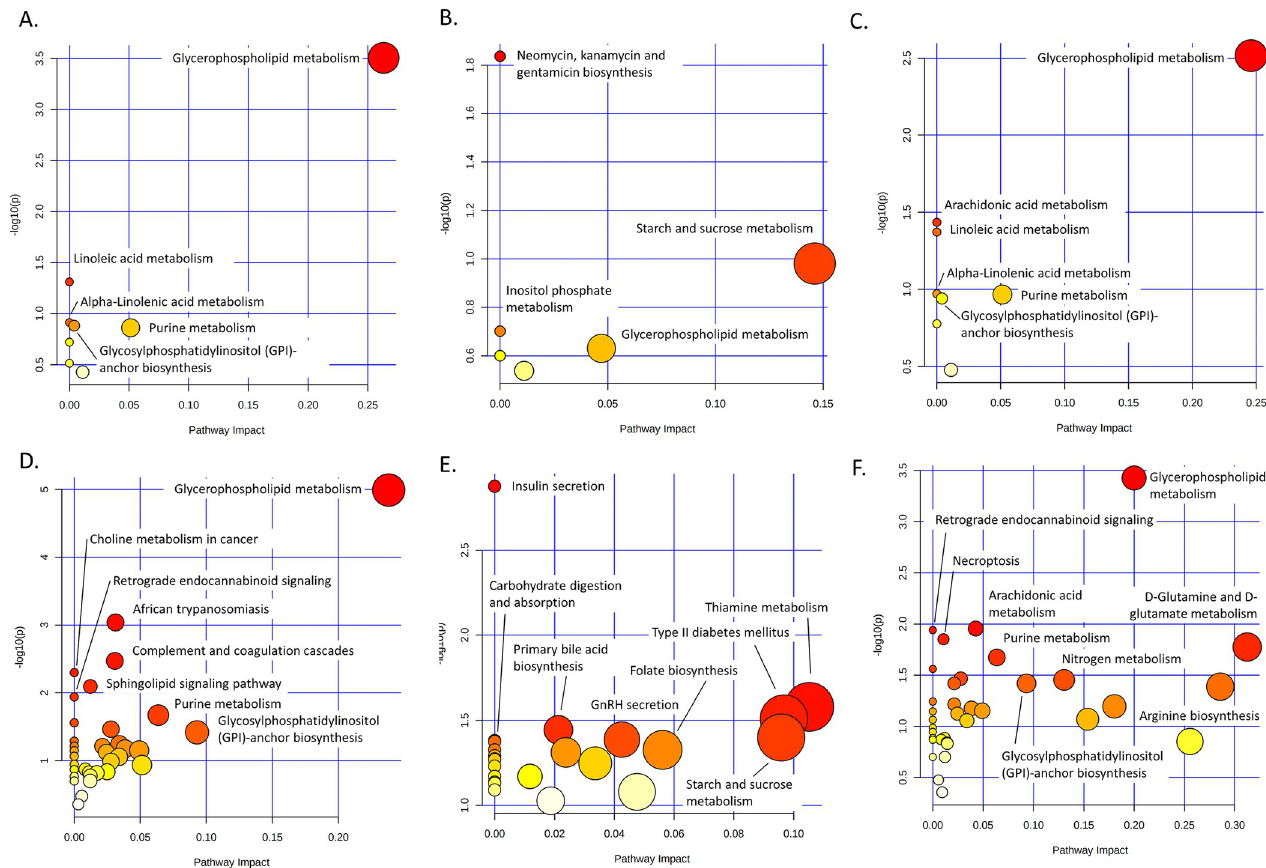
Fig 4. Pathway analysis of metabolomic data and integrated proteomic and metabolomic data (A) Metabolomic data for 2-weeks PI; (B) Metabolomic data for 4-weeks PI; (C) Metabolomic data for 8-weeks PI; (D) Combined proteomic and metabolomic data for 2-weeks PI; (E) Combined proteomic and metabolomic data for 4-weeks PI; (F) Combined proteomic and metabolomic data for 8-weeks PI. Among all identified pathways, glycerophospholipid metabolism pathway was significantly presented at 2-, and 8-weeks PI with high pathway impact. The pathway analysis highlights glycerophospholipid metabolism as the potential pathway involving with